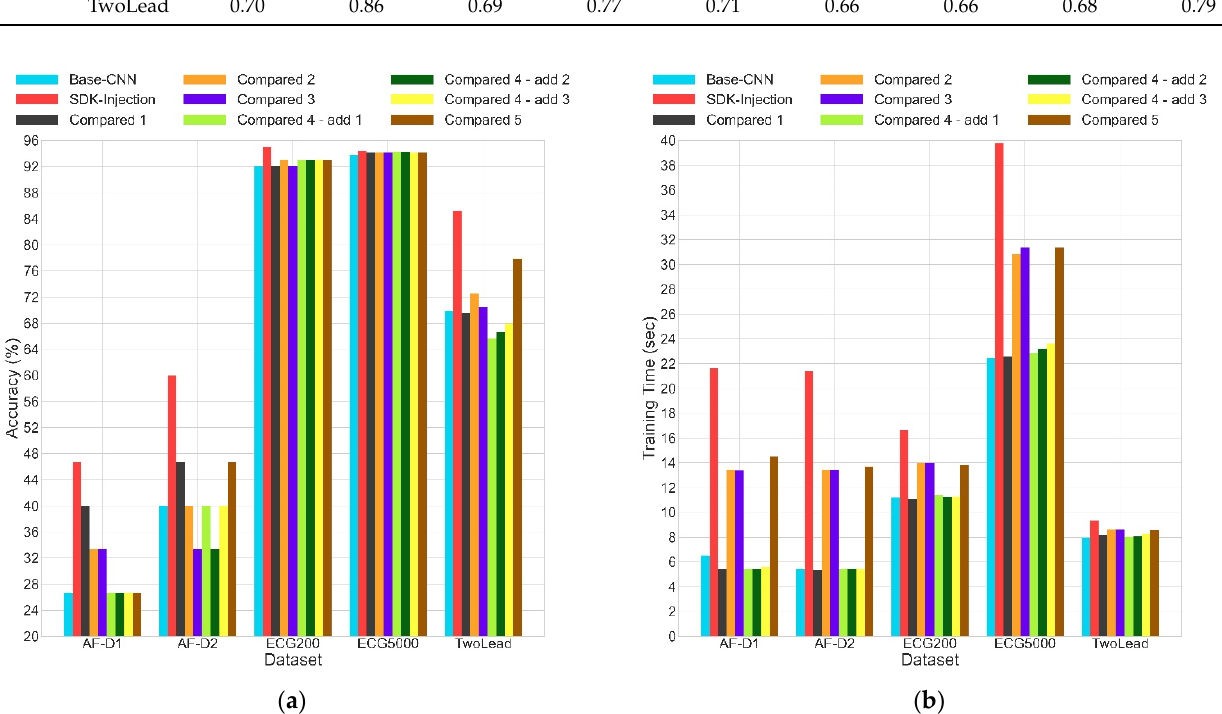
Figure 11. Performance when applying SDK-Injection and other comparison methods on each dataset: ( a ) accuracy when applying SDK-Injection and other comparison methods on each dataset; ( b ) training time for the same situation. Table 6. Performance evaluation of Base-CNN, SDK-Injection, and other comparison methods.